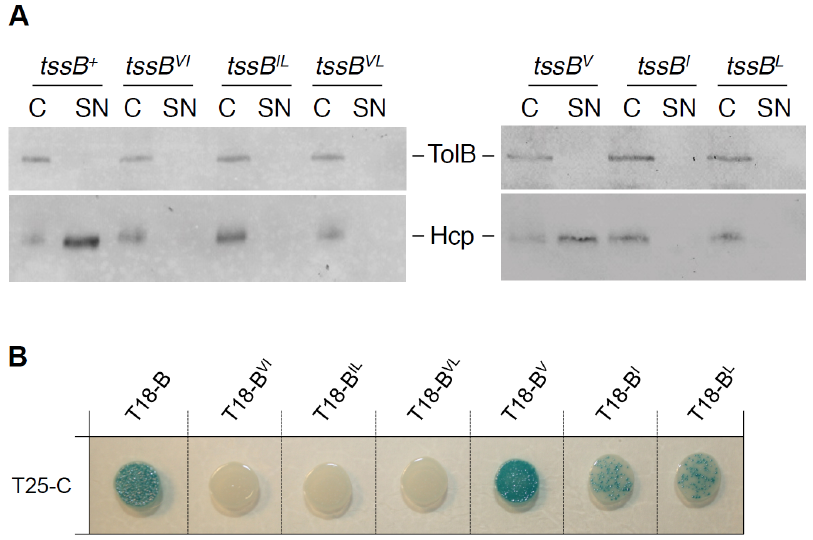
Figure 4. Mutagenesis study of the hydrophobic motif of the TssB1 a -helix. (A) Hcp release assay. Hcp FLAG release was assessed by separating whole cells (C) and culture supernatant (SN) fractions from 2 6 10 9 D tssB1 cells producing TssB1 ( tssB + ) or TssB1 bearing double or single substitutions within the hydrophobic motif ( tssB VI , V106W-I110W; tssB IL , I110W-L117W; tssB VL , V106W-L117W; tssB V , V106W; tssB I , I110W; tssB L , L117W). Proteins were separated by 12.5%-acrylamide SDS-PAGE and Hcp and TolB were immunodetected using anti-FLAG monoclonal (lower panel) and anti-TolB polyclonal (upper panel) antibodies. (B) Bacterial two-hybrid assay. BTH101 reporter cells producing the T25 domain of the Bordetella adenylate cyclase fused to TssC1 (T25-C) and the T18 domain fused to TssB1 (T18-B) or TssB1 variants bearing substitutions within the hydrophobic motif (T18-B VI , V106W-I110W; T18-B IL , I110W-L117W; T18-B VL , V106W-L117W; T18-B V , V106W; T18-B I , I110W; T18-B L , L117W) were spotted on X-Gal indicator LB agar